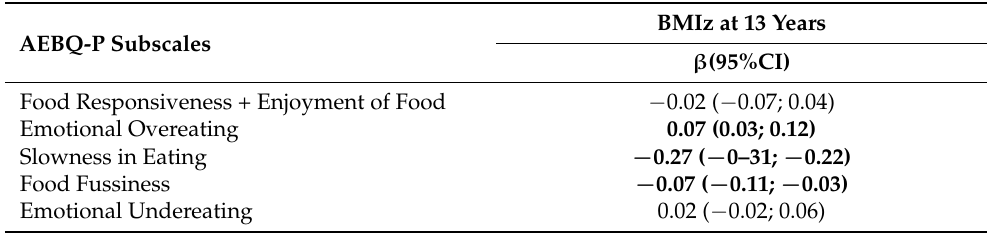
Table 5. Generalized linear regression analyses between the five proposed AEBQ-P subscales and BMIz among Portuguese